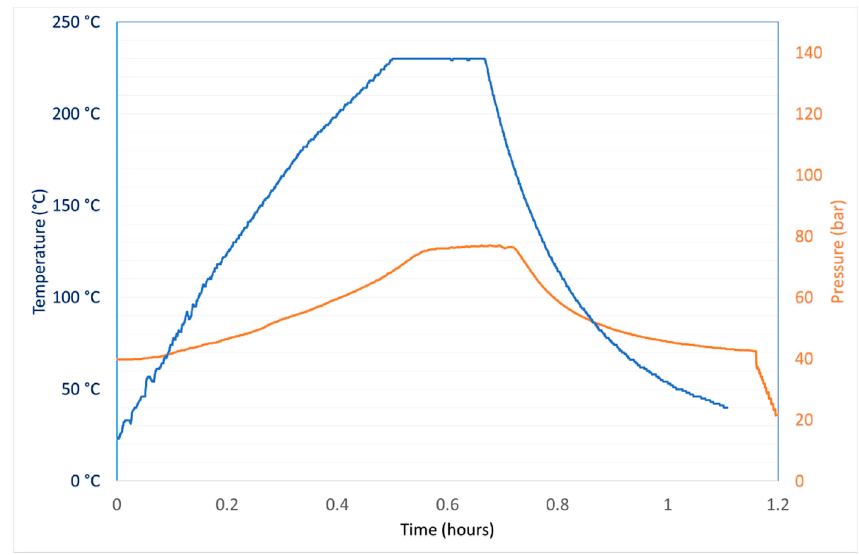
Figure 1. Trends of temperature and pressure inside vessels along a typical mineralization cycle of 0.3 g of an e-liquid dissolved in 0.5 cm 3 of HNO 3 and 6 cm 3 of water.